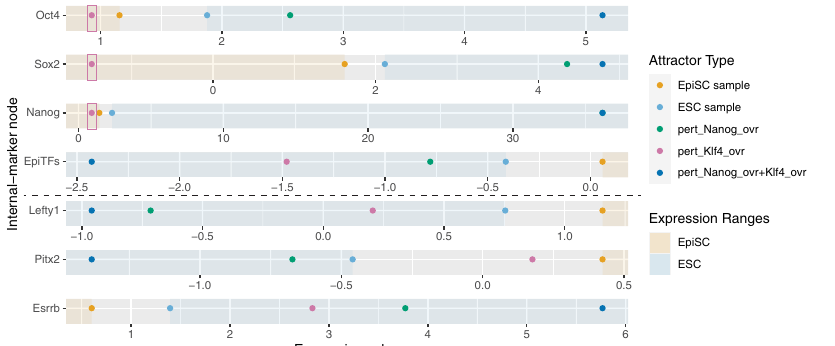
Fig. 6 Results of simulations of perturbations on FVS control nodes for EpiSC reprogramming to ESCs. Expression value plots for SFA simulations of perturbations on FVS control nodes in the pluripotent stem cell model. Each plot contains the expression values of one internal-marker node at the attractor states generated from the initial conditions: EpiSC and ESC from the available gene expression data, in addition to the speci fi ed perturbations on FVS control nodes (pert_Nanog_ovr, pert_Klf4_ovr, pert_Nanog_ovr + Klf4_ovr). Shaded regions of the plots indicate the ranges of either ESC (blue) or EpiSC (gold) expression values. A perturbation is considered successful if 90% of the internal-marker nodes have expression values within the gene expression range of the ESC-associated attractor. In other words, the colored dot for a speci fi ed perturbation should be within the blue-shaded ESC region of at least 90% of the internal-marker nodes to pass the second fi ltering criterion. Plots using the four internal-marker nodes used in Yachie-Kinoshita et al. are above the dotted line. Plots using the additional three internal-marker nodes identi fi ed are below the dotted line. We note that the Klf4 overexpression (pert_Klf4_ovr) suggested by Yachie-Kinoshita et al., does not pass the internal-marker node fi ltering criterion because the expression values of Oct4, Sox2, and Nanog have not reached the threshold of the expression value in the attractor produced from ESC gene expression data (pink boxes). However, in addition to the Nanog overexpression (pert_Nanog_ovr) perturbation identi fi ed by Yachie-Kinoshita et al., NETISCE identi fi ed the combination of Nanog and Klf4 overexpression (pert_Nanog_ovr + Klf4_ovr) to pass both machine learning and internal-marker node fi ltering